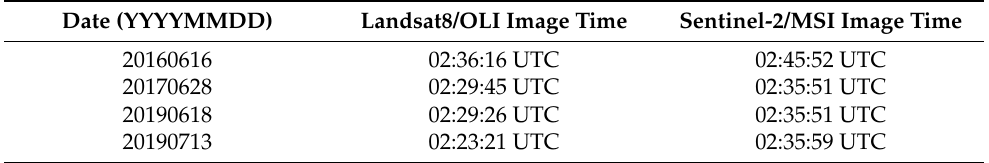
Table 2. Landsat8/OLI and Sentinel-2/MSI image